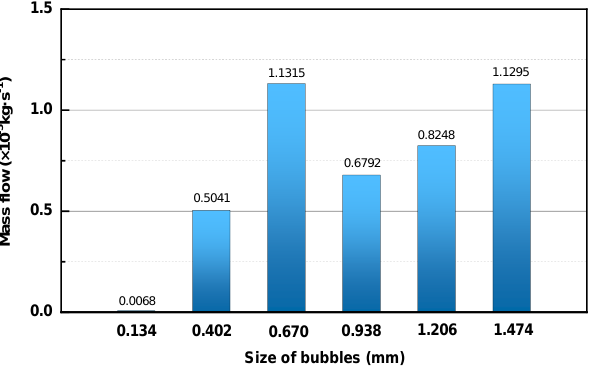
Figure 8. Mass flow of bubbles with varied sizes in the numerical simulation.